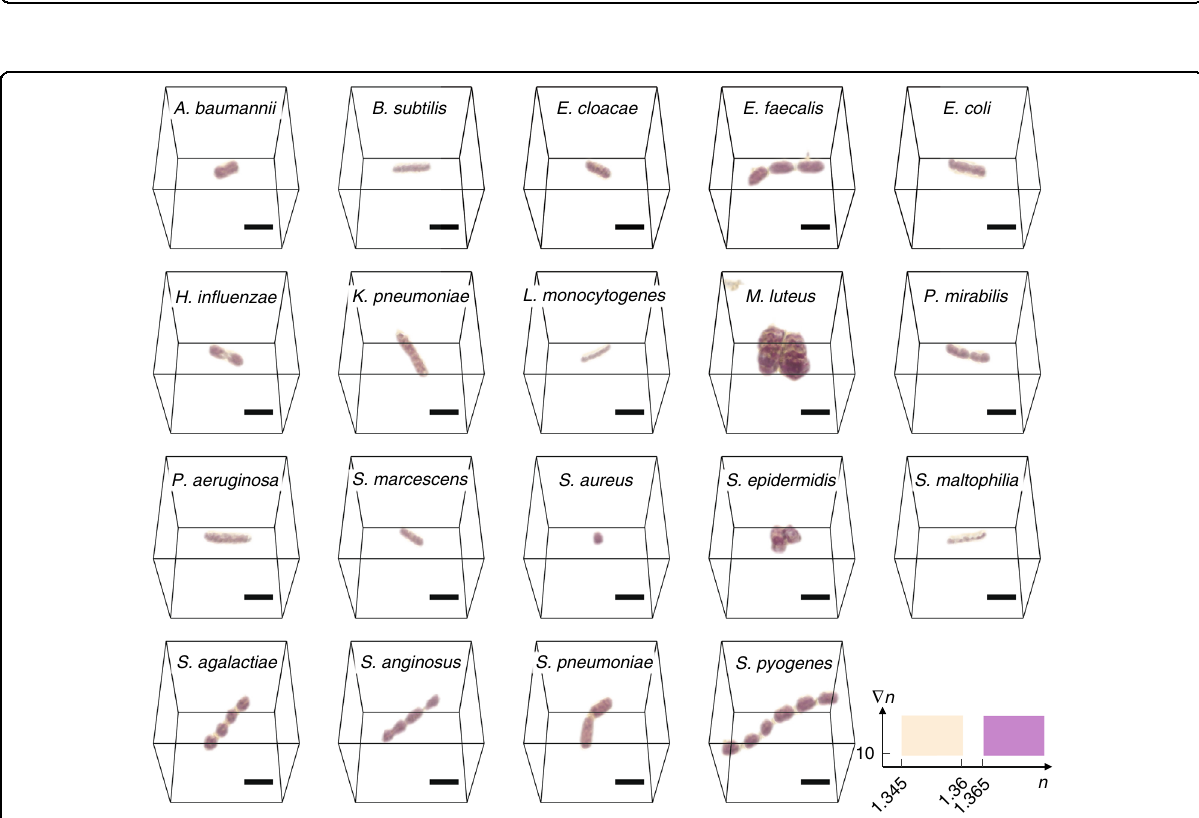
Fig. 3 Three-dimensional (3D) RI tomograms of bacterial BSI pathogens. Representative tomograms addressed in our study are rendered in 3D. Each tomogram represents an individual species of bacterial BSI pathogens. Scale bar = 2 μ